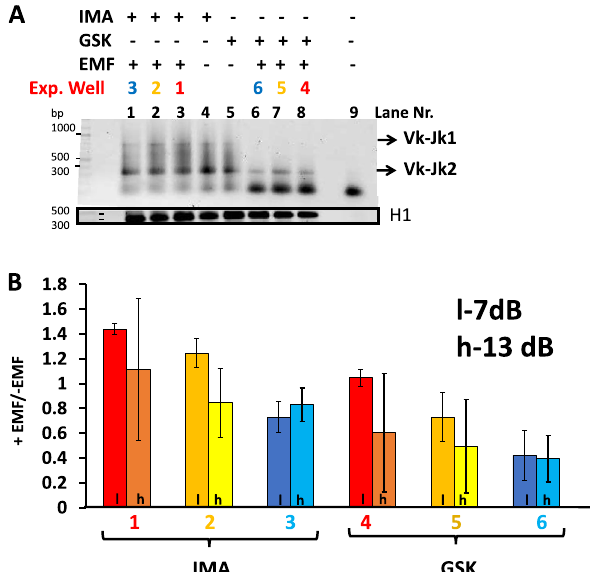
Figure 3. A two steps PCR recombination assay is used to identify Vk to Jk1 or Vk to Jk2 rearrangements from pre-B cells upon RAG induction with Imatinib or GSK. ( A ) A Sybr Green stained 1.5% Agarose TBE gel in which the recombination PCR reactions templated with initial 1:5 dilutions of genomic DNA extracted from each distinct cell treatment lot (2 × 10 6 cells) are electrophoretically resolved. The cells were either unexposed (gel reaction lanes 4 and 5) or subjected for 48 h to 1 GHz EMF irradiation (lanes 1 to 3 and 6 to 8) with the generator setting at 13 dBm. The color code designating the positions of exposed EMF (exp.Well) wells in the dish is the same with the one used in supplementary Fig. 1Sb. Last lane (9) of the gel, -DNA control reaction. The bottom black box (cropped from a distinct gel) displays Hisone H1 PCR reactions templated with the same amount of genomic DNA as the recombination reactions above(control genomic DNA). ( B ) Identified Vk to Jk2 recombined products were quantified from scanned gels corresponding to PCR reactions from cells +/− Irradiation and the calculated ratios of band intensities expressed + EMF/−EMF(irradiated/nonexposed) for each well (color code consistent with that shown in Fig. 1S). The histograms represent the average values of three independent quantified experiments. EMF-Electromagnetic Field, Recombination pharmacological stimuli (Imatinib, IMA) versus (GSK-690693, GSK). H1, histone H1 control reaction PCR reactions. Darker font histograms correspond to lower 7 dBm (l) and brighter to higher 13 dBm(h) generator power